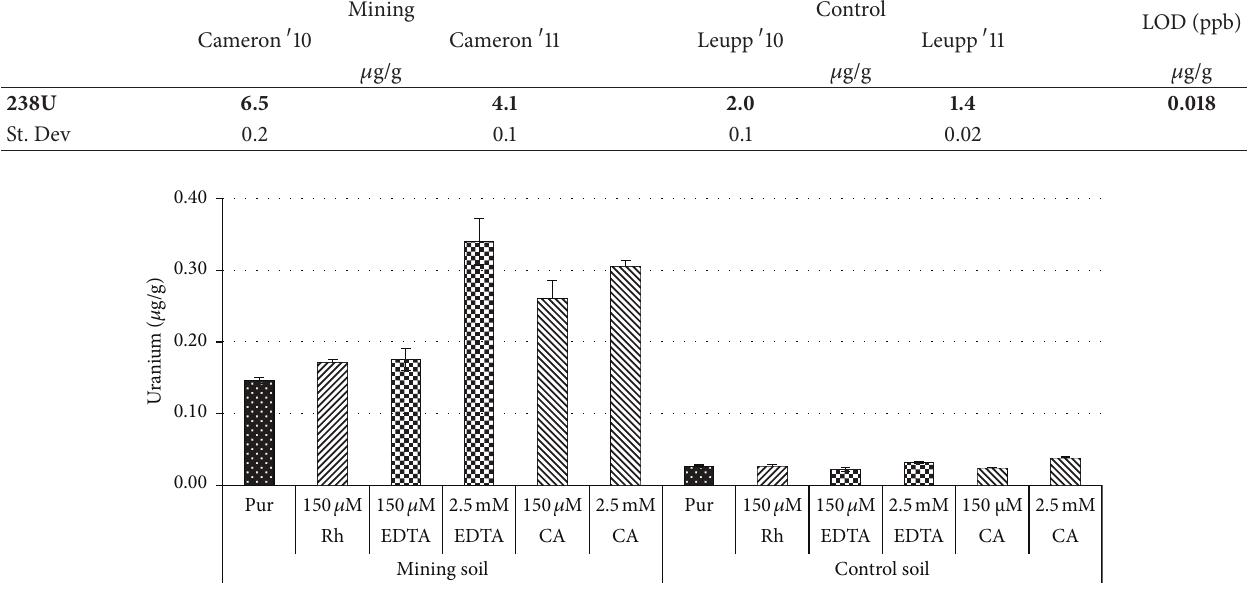
Figure 2: Removal of uranium from the mining and control soils utilizing rhamnolipid (150 𝜇 M), EDTA (150 𝜇 M and 2.5 mM), and citric acid (150 𝜇 M and 2.5 mM). Pur: purified water (18M Ω ⋅ cm), Rh: rhamnolipid, and CA: citric acid.